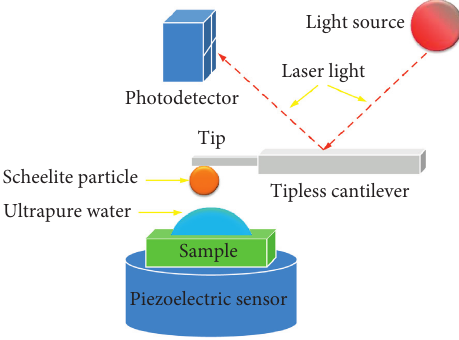
Figure 4: Schematic diagram of